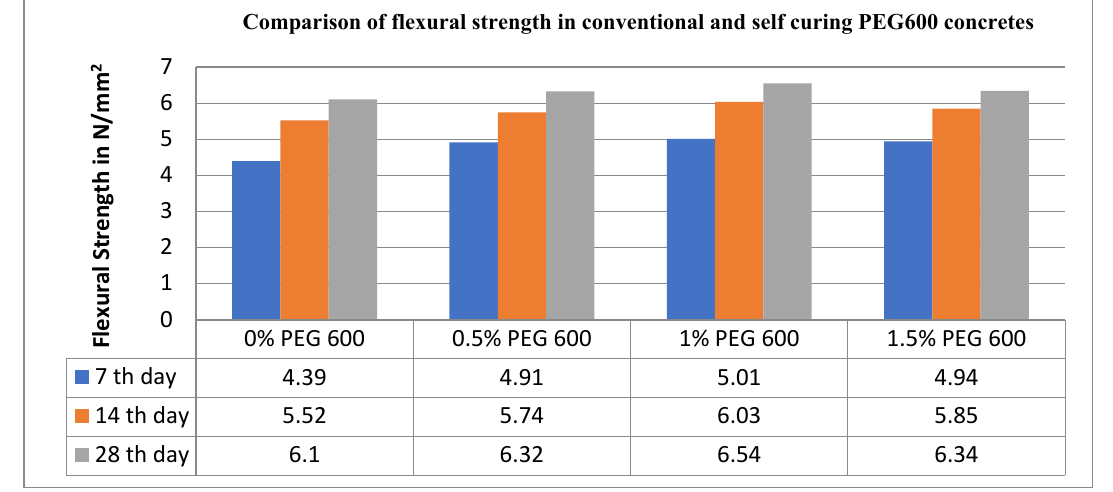
Figure 5. Comparison of flexural strengths of Conventional and PEG-600 concretes.